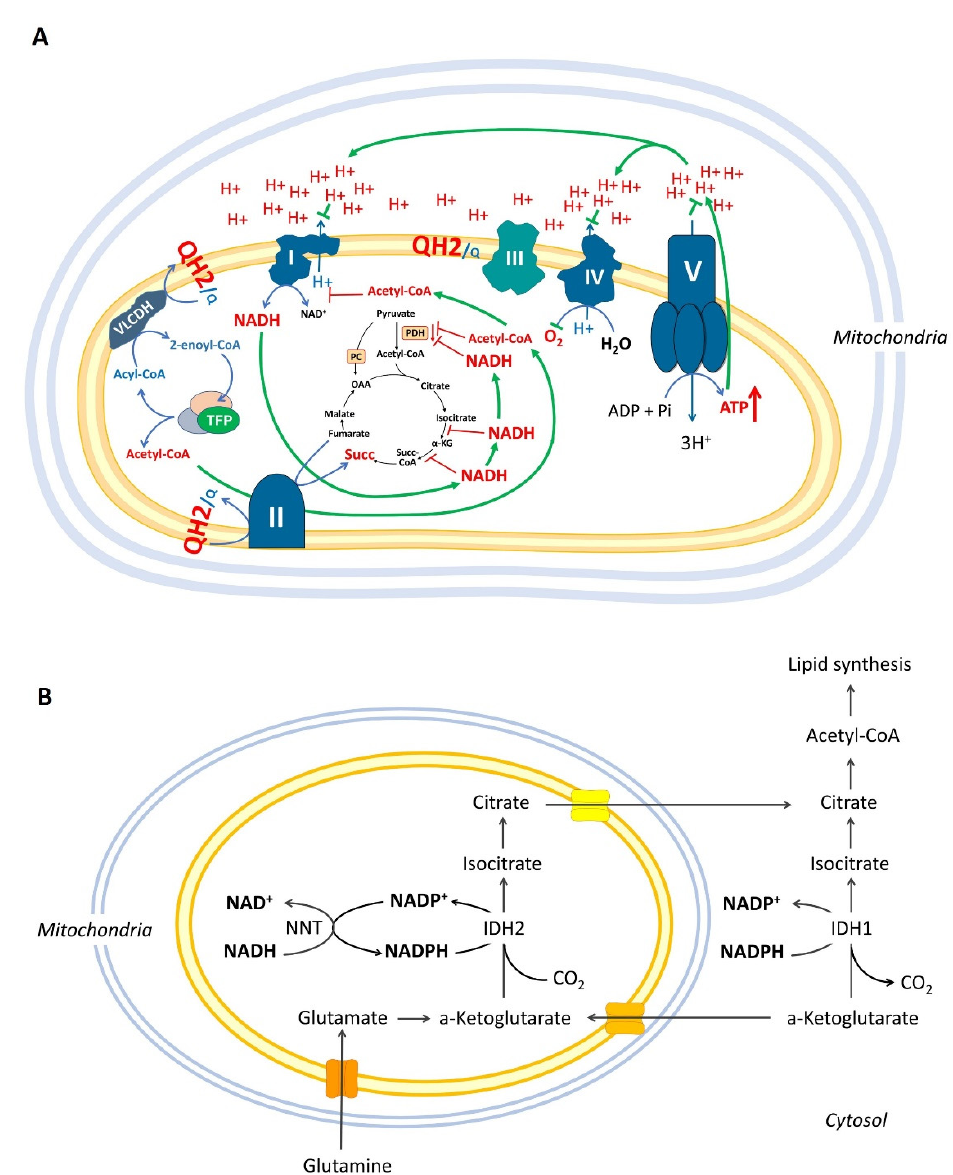
Figure 1. ( A ) Possible consequences of the overactivated β -oxidation in mitochondria: high Q10H 2 /Q10 ratio and accumulation of acetyl-CoA and succinate. This could lead to high levels of NADH and acetyl-CoA that inhibit the Krebs cycle, PDH, and complex I of the mitochondrial ETC. The green arrows indicate accumulated metabolites. The red blunt ends indicate the inhibition of a particular enzyme. ( B ) NNT-catalyzed conversion of NADH to NADPH in mitochondria and reductive carboxylation of α -ketoglutarate to isocitrate, catalyzed by IDH1 and IDH2. Abbreviations: ETC: electron transport chain; α -KG: α -ketoglutarate; IDH: isocitrate dehydrogenase; NNT: NAD(P) transhydrogenase; OAA: oxaloacetate; Q: Coenzyme Q10 (oxidized form); QH 2 : coenzyme Q10 (reduced form); PDH: pyruvate dehydrogenase; PC: pyruvate carboxylase; Succ: succinate; Succ-CoA: succinyl-CoA; TFP: trifunctional protein; VLCDH: very long chain acyl CoA dehydrogenase.